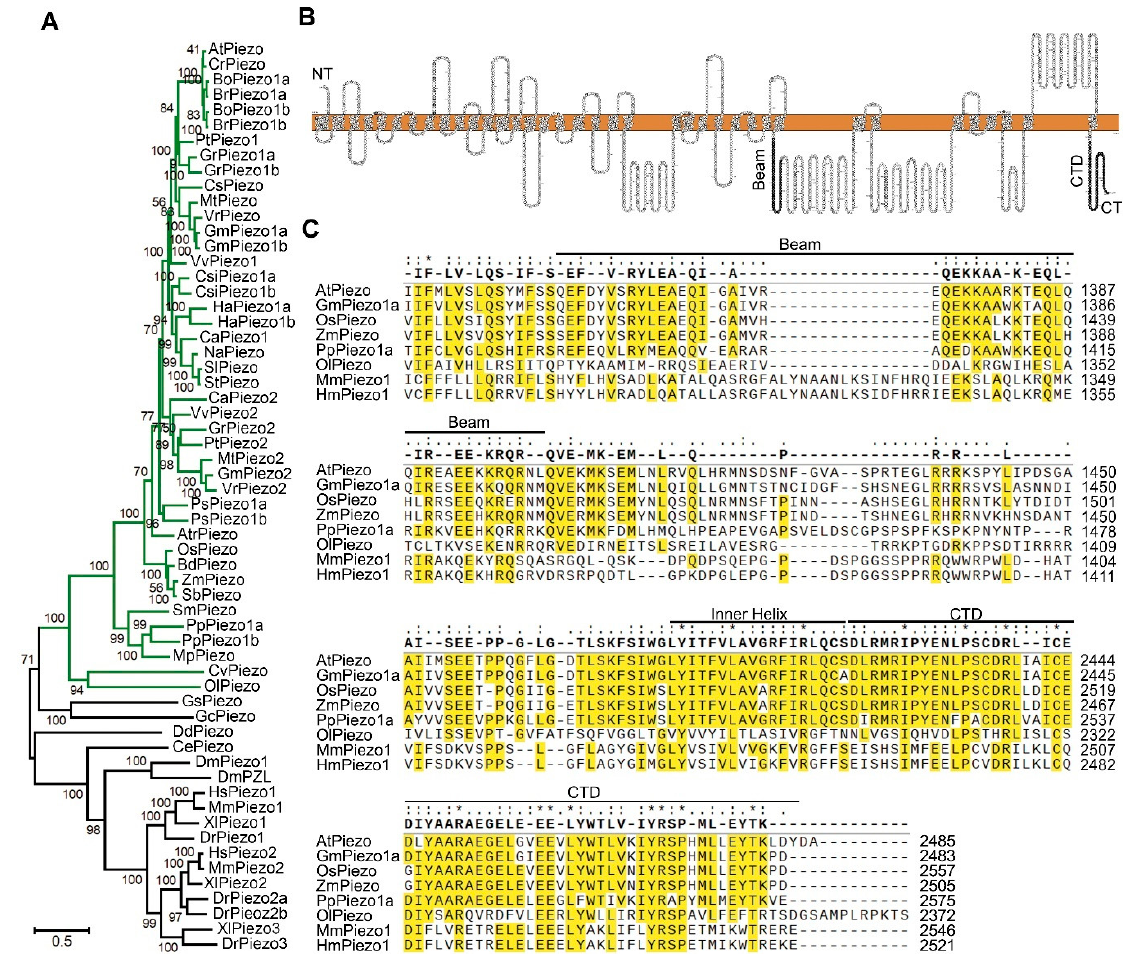
Figure 1. Evolutionary Analysis of Piezo in Plants. ( A ) Maximum likelihood unrooted phylogenetic tree of Piezo homologs. Green branches belong to the plant kingdom. ( B ) Predicted topology of the AtPiezo monomer. Beam and CTD domains are indicated in black. ( C ) The alignment of beam, inner helix and CTD domains of AtPiezo and its orthologs. Protein multiple sequence alignment of AtPiezo ( Arabidopsis thaliana ), GmPiezo1a ( Glycine max ), OsPiezo ( Oryza sativa Japonica Group ), ZmPiezo ( Zea mays ), PpPiezo1a ( Physcomitrella patens ), OlPiezo ( Ostreococcus lucimarinus ), MmPiezo1 ( Mus musculus ), and HmPiezo1 ( Homo sapiens ). The highly conserved amino acids among Piezo orthologues are highlighted in yellow. The consensus is with a threshold of